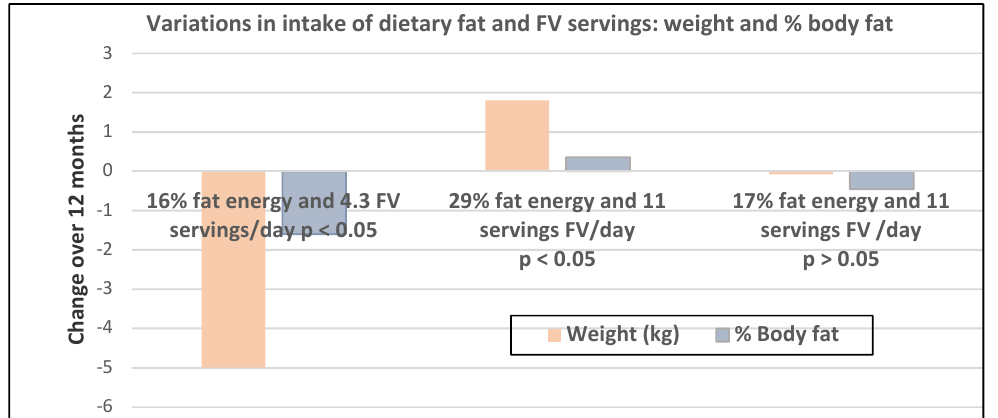
Figure 14. Weight-related changes from baseline with variation in % energy from fat and level of fruit and vegetable (FV) intake, including 100% juice, dried fruit, and starchy vegetables in 122 overweight women (mean age 38 years) over 12 months [47].